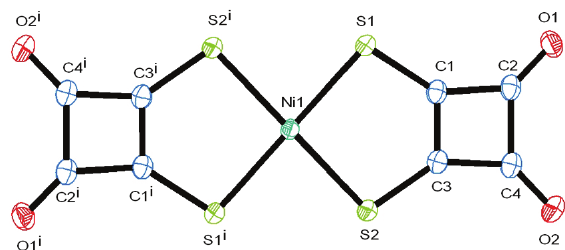
Figure 3. ORTEP plot of the complex dianion in bis(n-butyltrip- henylammonium)-bis(1,2-dithiosquarato)nickelate(II), (BuPh ] . 2